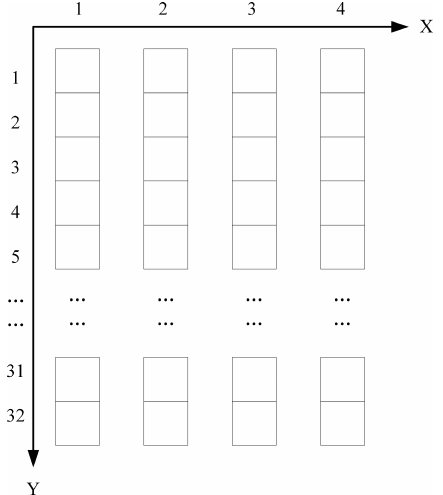
Figure 1. Detector array diagram of